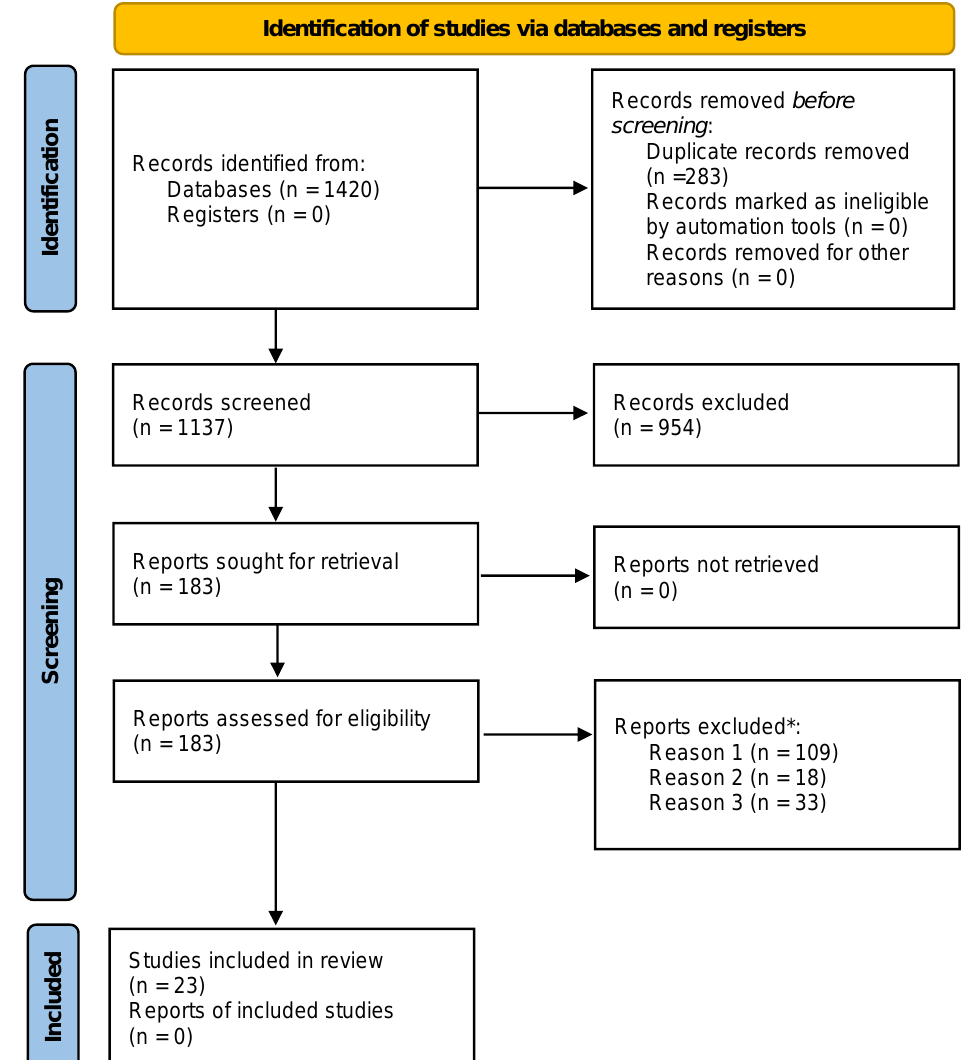
Figure 1. Flow chart of the systematic literature search according to PRISMA 2020 guidelines [28], using the PubMed and Web of Science databases as detailed in the main text, for records published in or after 1994, with the record identification (data extraction) completed in April 2021. * For reports excluded for multiple reasons, only the primary exclusion criterion is counted here (i.e., each excluded report is only counted once). The primary reasons for exclusion of reports were as follows. Reason 1: Diagnostic outcome information was insufficient (did not explicitly consider the transition from Mild Cognitive Impairment to Alzheimer’s disease); Reason 2: Data parameters prevented inclusion into mean ± standard deviation at baseline such as where ratios between markers were reported, or because the population sampled was too small <30); Reason 3: Analysis in a report replicated